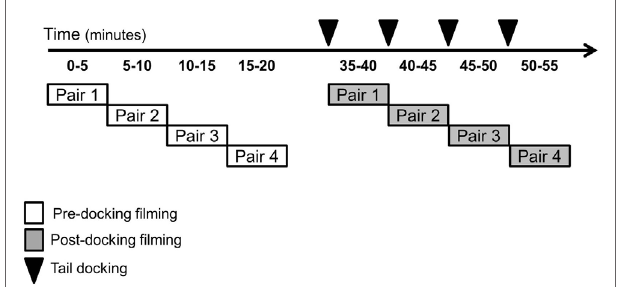
FigUre 2 | Timeline of the experimental procedure .